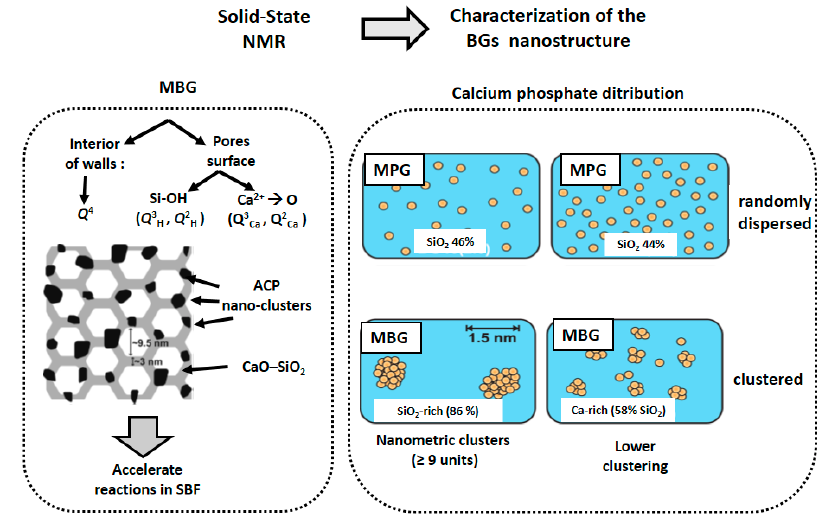
Figure 6. Solid state NMR allowed the determination of nanostructural features of BGs influencing the behavior in SBF. Left : The proposed model for MBGs contains ACP nanoclusters able to accelerate the reactivity in SBF. Right : NMR was also able to establish differences between MPGs and MBGs. In MPGs, phosphate ions are randomly dispersed, whereas in MBGs, nanometric clusters are formed whose size increases when the SiO 2 in the glass increases.